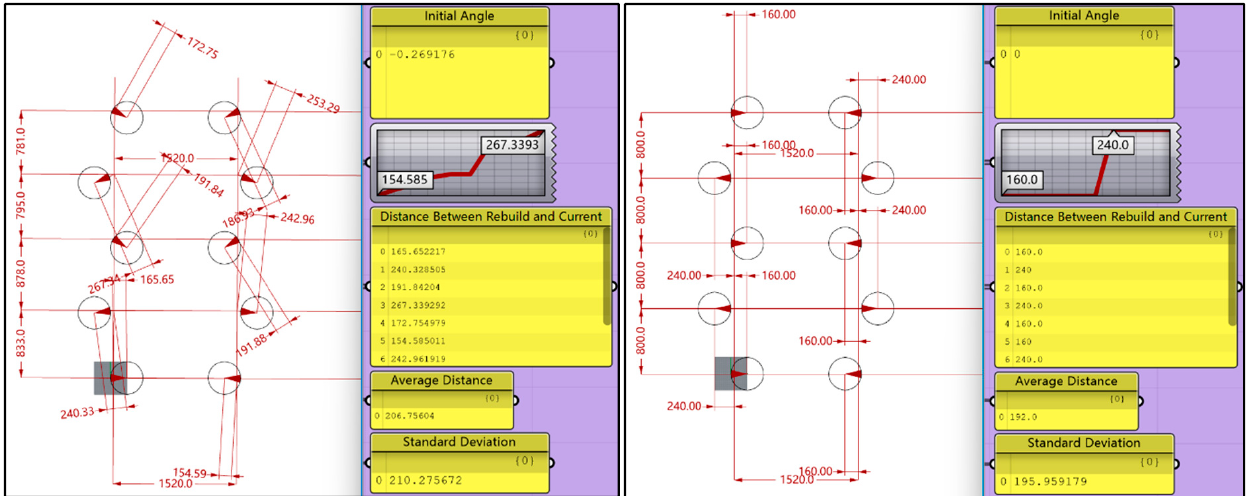
Figure 18. Verification of 10 symmetric columns (the disordered axes on the left, the result axes on the right).